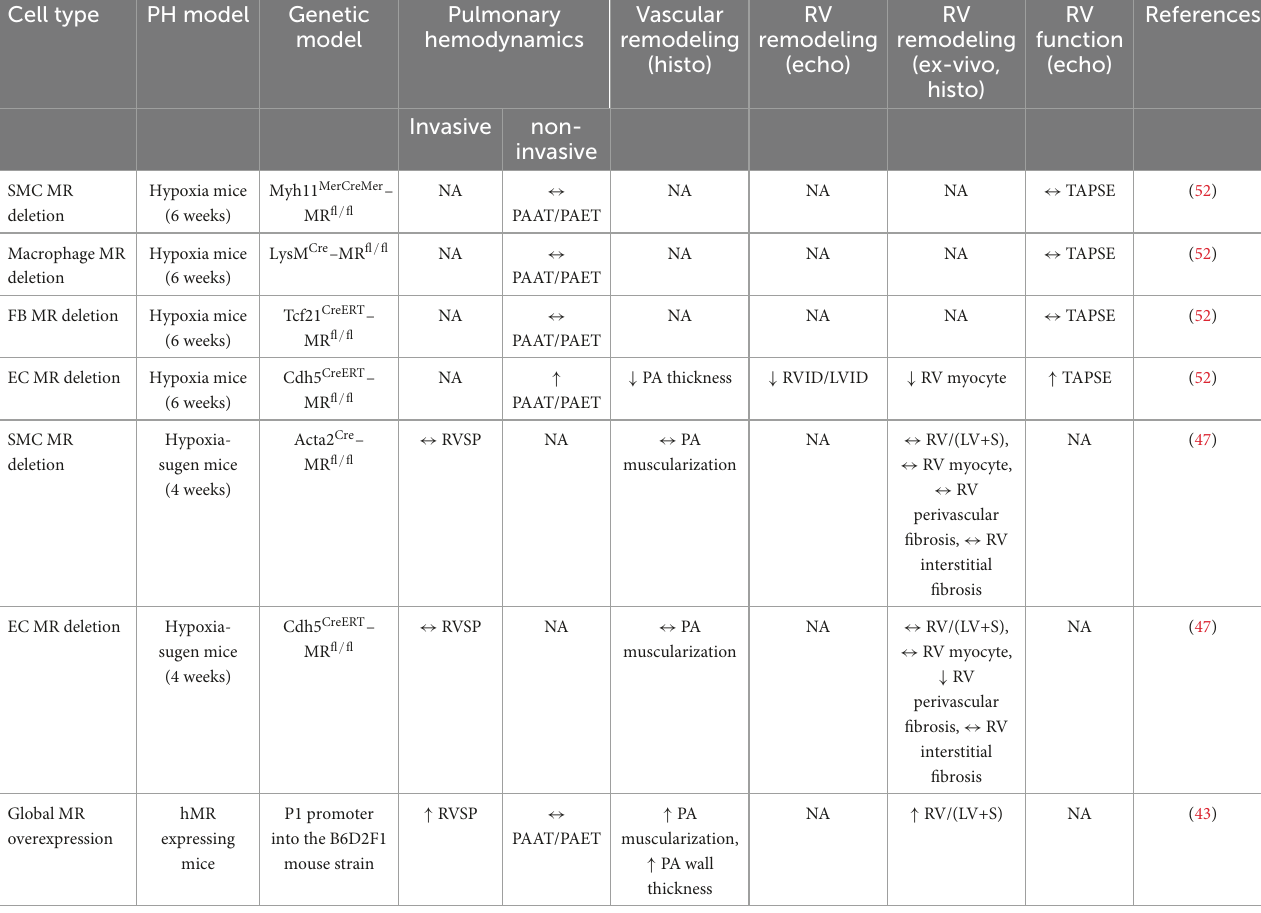
TABLE 3 Summary of studies evaluating the effects of genetic manipulation of mineralocorticoid receptor (MR) on the pulmonary vasculature and right ventricle in rodent models. Cell